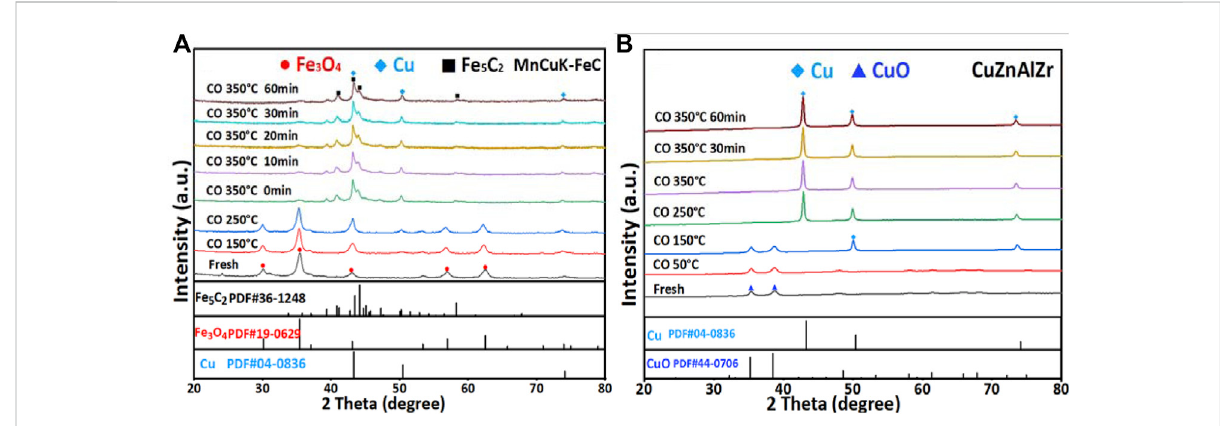
FIGURE 2 In-situ XRD patterns during CO treatment of (A) MnCuK-FeC catalyst and (B) CuZnAlZr